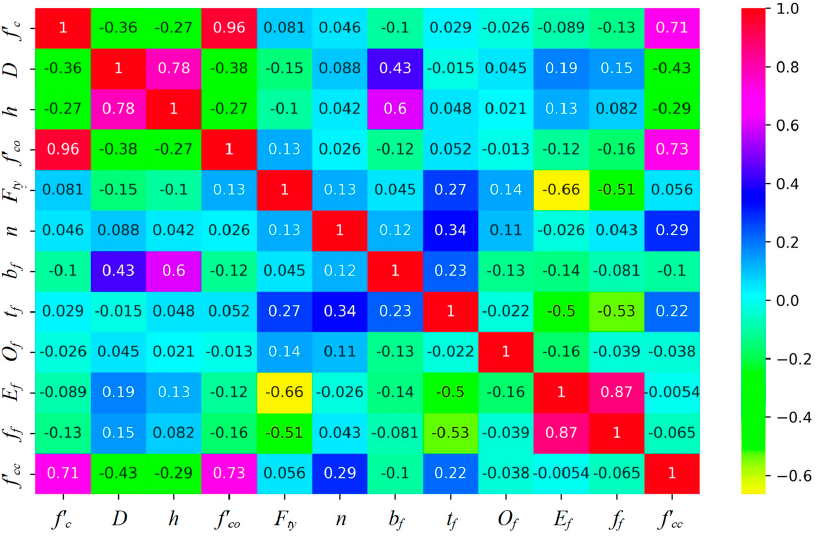
Figure 2. Heat plot of input and output parameters.